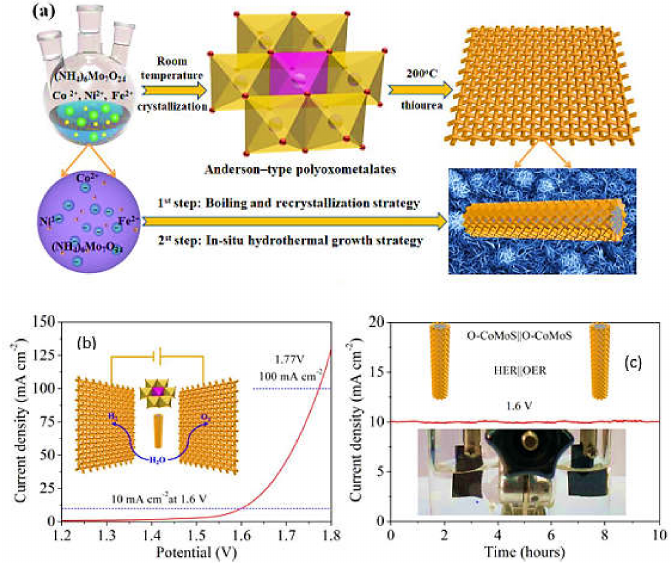
Figure 10. ( a ) Schematic illustration of the synthesis of as-prepared oxygenated-bimetal- sulfide hetero-nanosheet arrays grown on carbon fiber cloth by use of Anderson- and ( c ) time dependence of current densities under different constant potentials by the use of an O-CoMoS array as a perspective anode and cathode for overall water splitting. Copyright 2018 by American Chemical Society